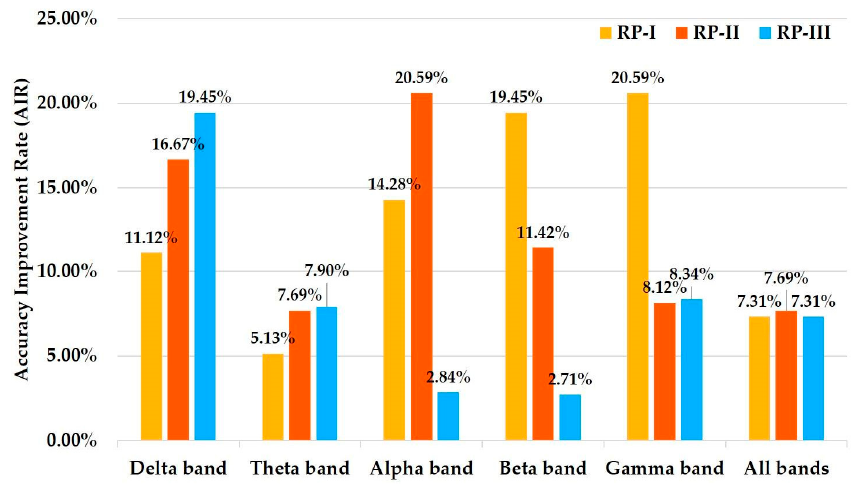
Figure 9. Emotion-induction state versus resting state accuracy improvement ratios.